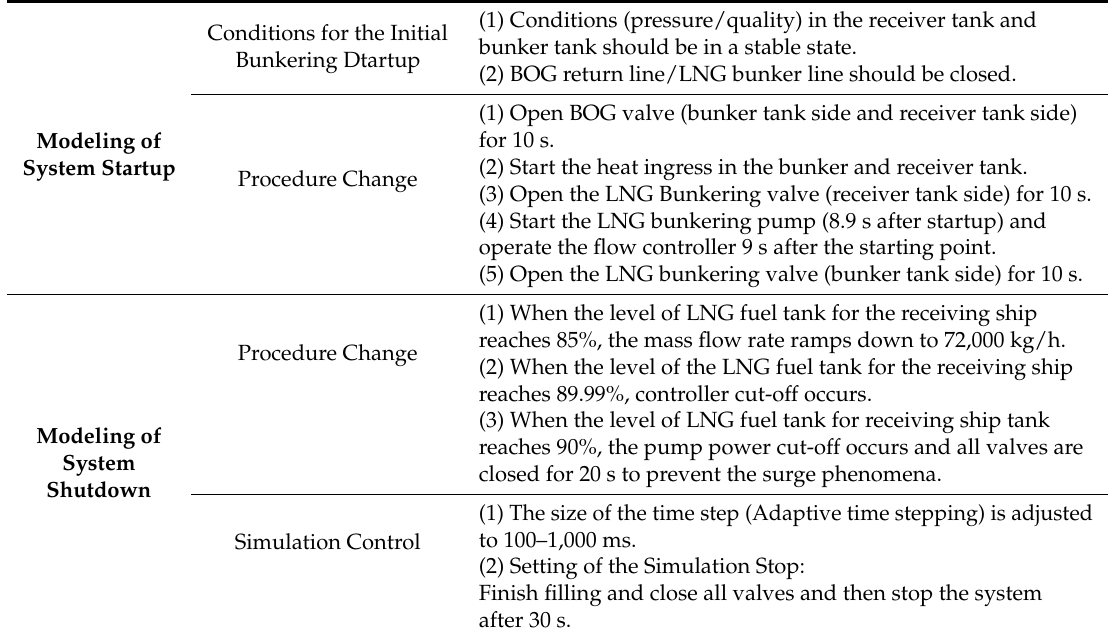
Table 3. Modeling of the system startup and